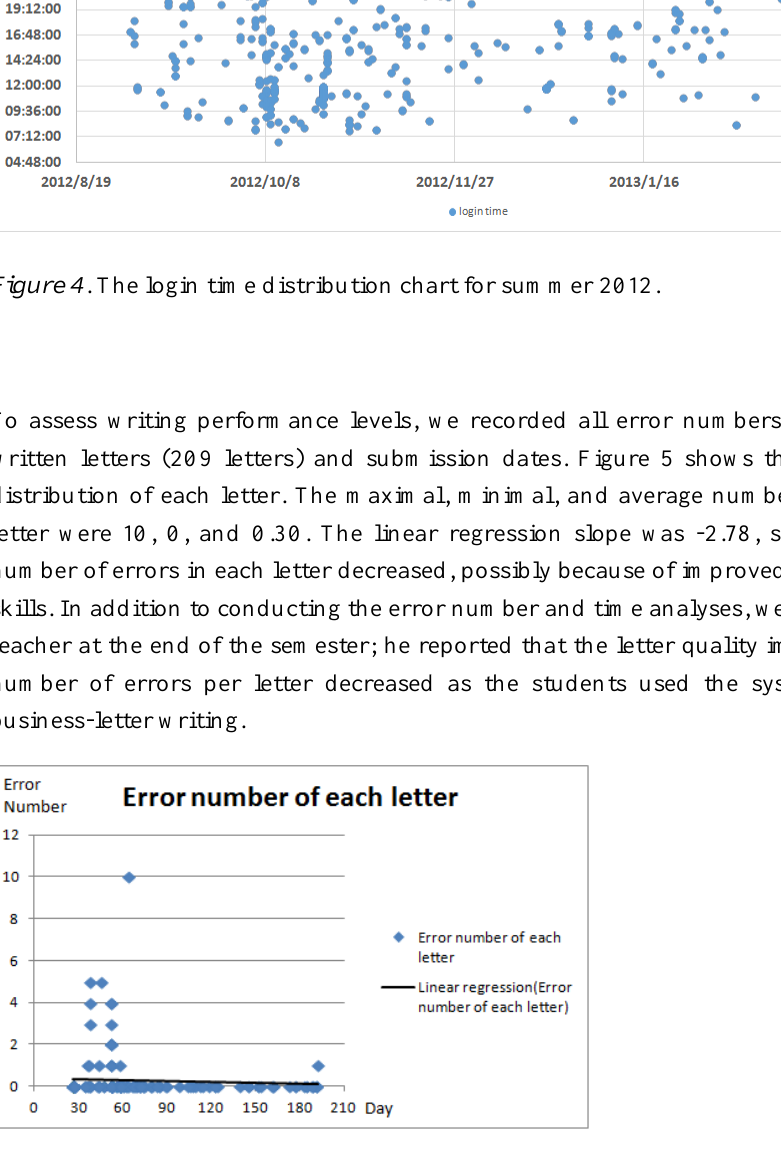
Figure 5 . The error number chart for each